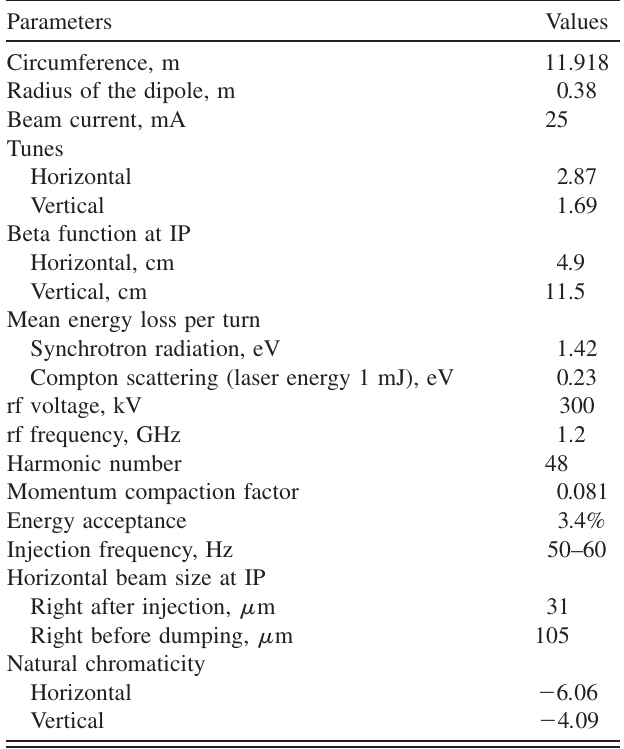
TABLE II. Parameters of the laser-electron storage ring.